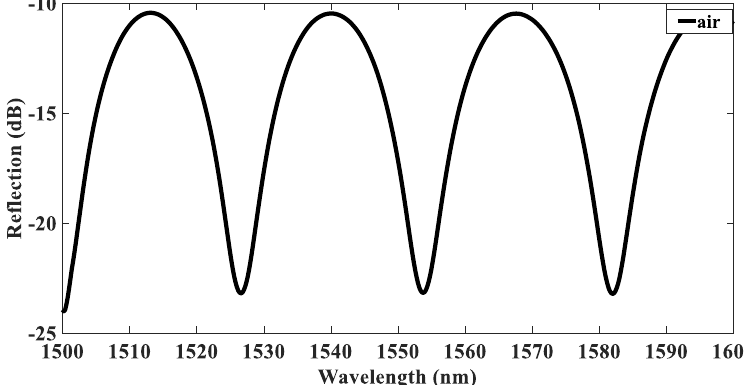
Figure 6. Interference spectrum of the AGFFPI with air in the gap and the ambient temperature of 25 °C.